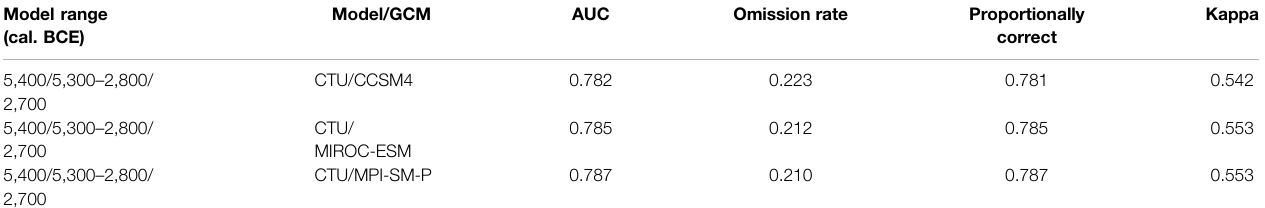
TABLE 5| Model performance ofCTU nichesreconstructed using bioclimatic variables provided byCCSM4,MIROC-ESM,MPI-ESM-P, and DEM-derivedterrainvariables. Model range (cal. BCE)